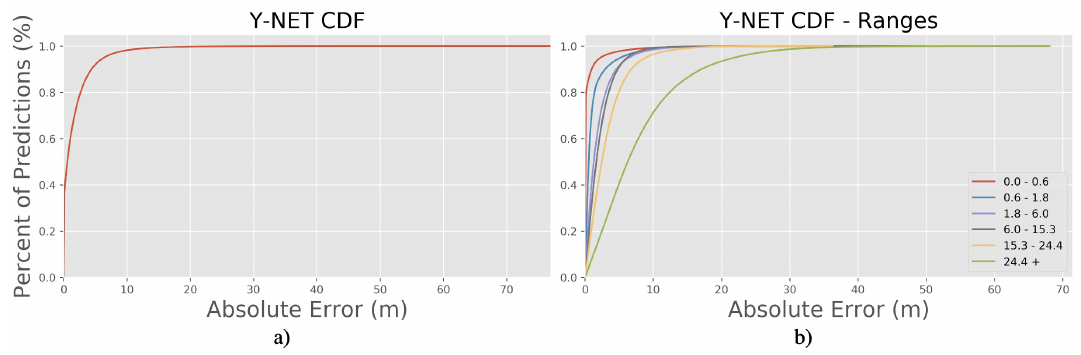
Figure 7. ( a ) Cumulative density function (CDF) of Y-NET for the test dataset. ( b ) CDF of Y-NET separated by height ranges for the test